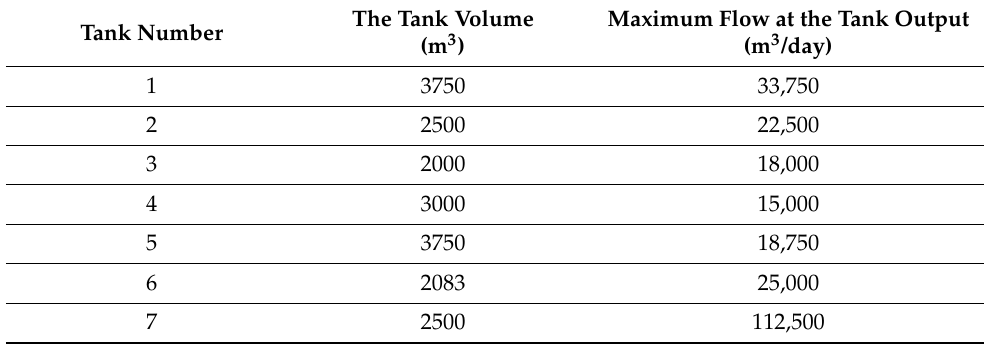
Table 2. The characteristics of the tanks of the sewer network.